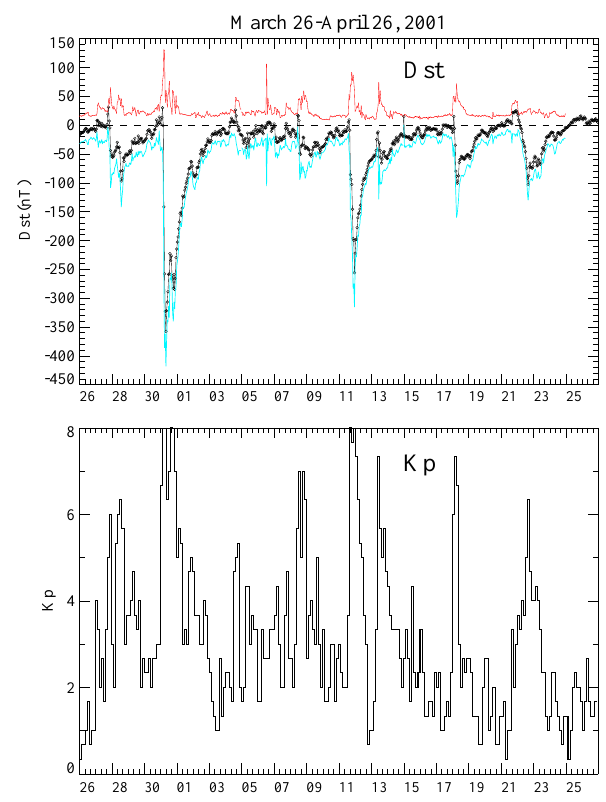
Fig. 10. K p and D st measurements for 26 March– 26 April 2001. The effect of the α -particles in calculating the magnetopause cur- rents (top red trace) has not been taken into account. For further details, see